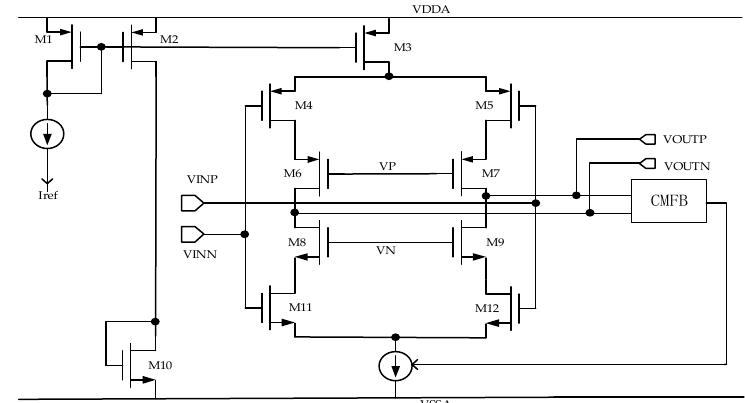
Figure 7. Second- and third-stage integrator op amps.